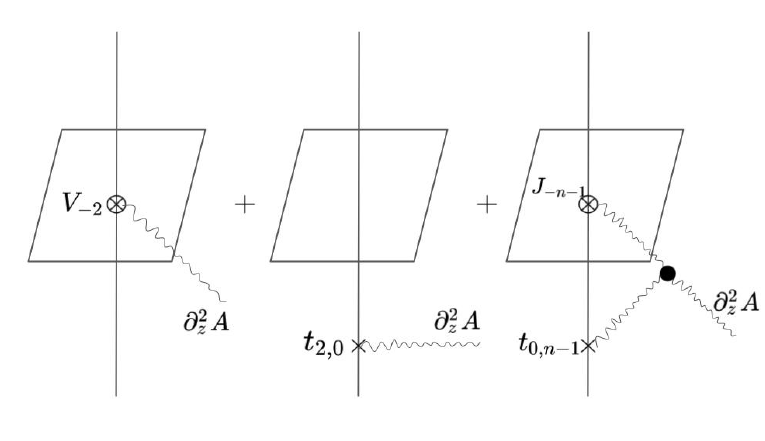
Figure 6: The Feynman diagram associated with the RHS of (25): + V + (cid:80) t nJ t − 2 n − 1 2,0 0, n − 1 n